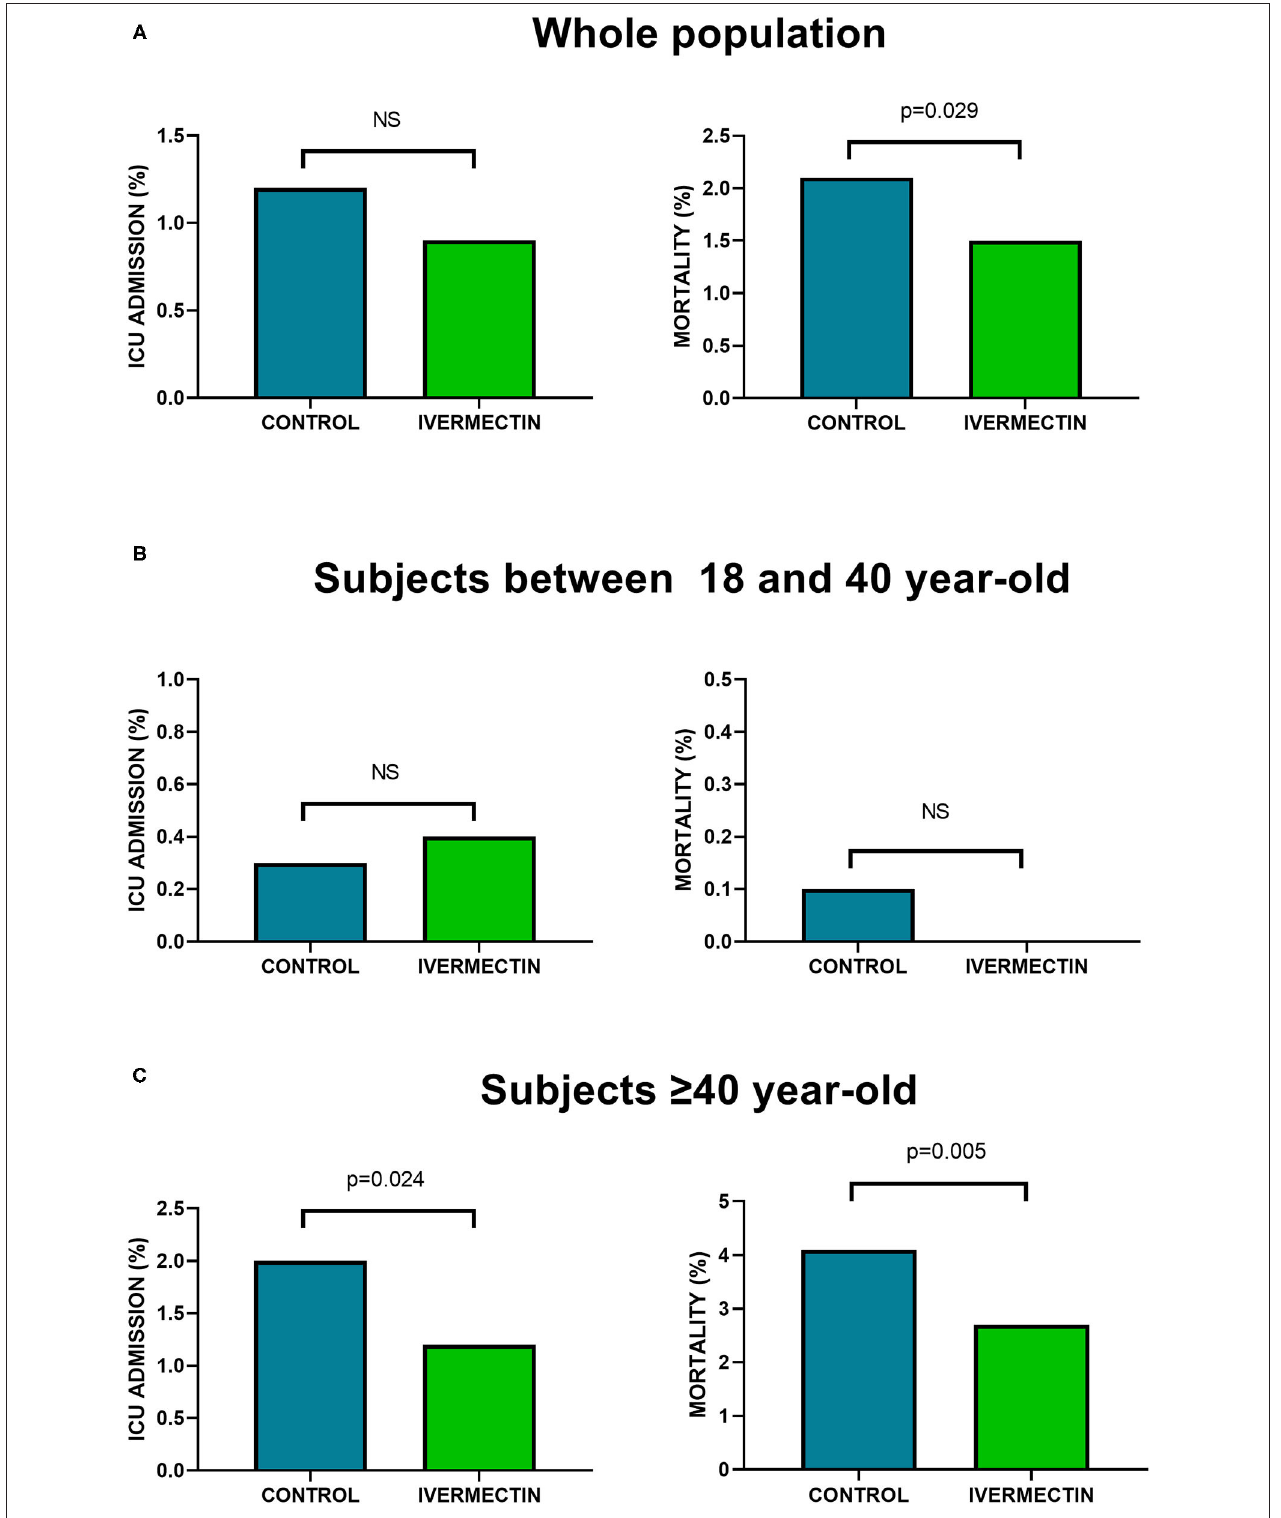
FIGURE 2 | ICU admission and mortality in IVM-ITT and C groups. (A) Whole population: analysis of all subjects (C n = 17,966; IVM-ITT n = 3,266); (B) Analysis of subjects ≥ 18 year-old and < 40 year-old (C n = 8,944; IVM-ITT n = 1,415); (C) Analysis of subjects ≥ 40 year-old (C n = 9,022; IVM-ITT n = 1,851). NS, non statistically significant; n, number of